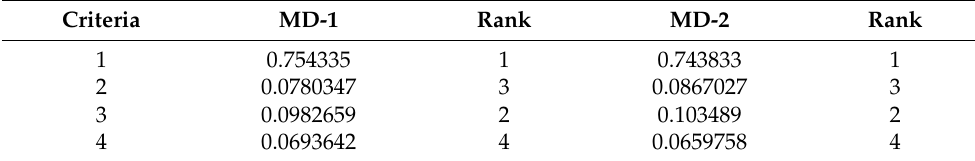
Table 12. Optimal weights obtained for case study using MD-1, and -2.